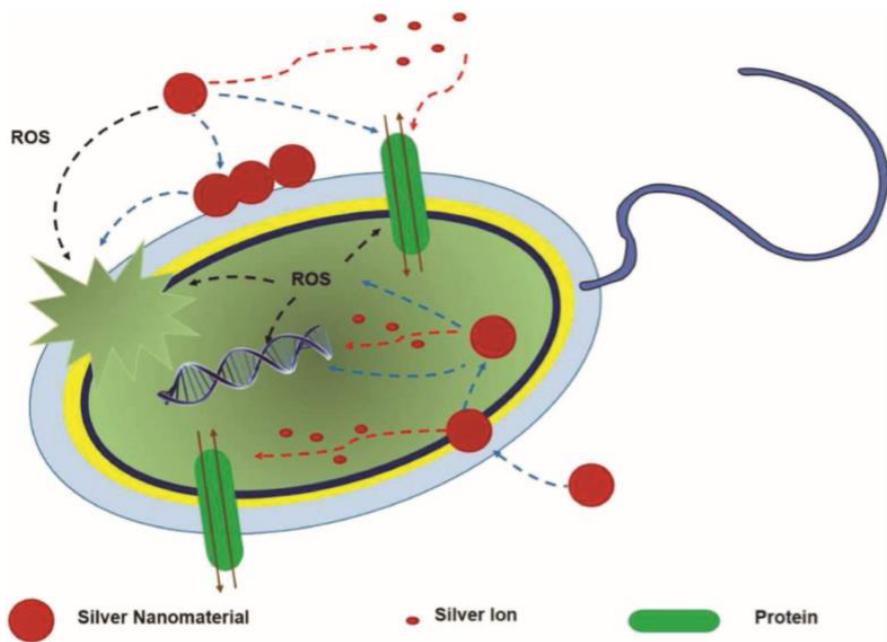
Figure 2. Interaction between silver nanoparticles and cells. Potential mechanisms in nanosilver activity are (1) attachment to cell membrane, to protein component of the membrane and DNA structure, resulting in function alteration (blue interrupted line marks the mechanism); (2) silver ions release, impacting the mem- brane, nucleic acids( DNA) and protein content of the cell (red interrupted line marks the described mechanism); (3) oxidative stress mounting as a result of reactive oxygen species release with effects on cell membrane, nuclei acids (DNA) and protein content of the membrane (the black interrupted line marks the mechanism)